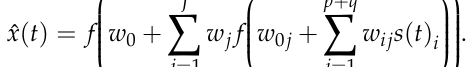
Table 2. Arrhythmia datasets.